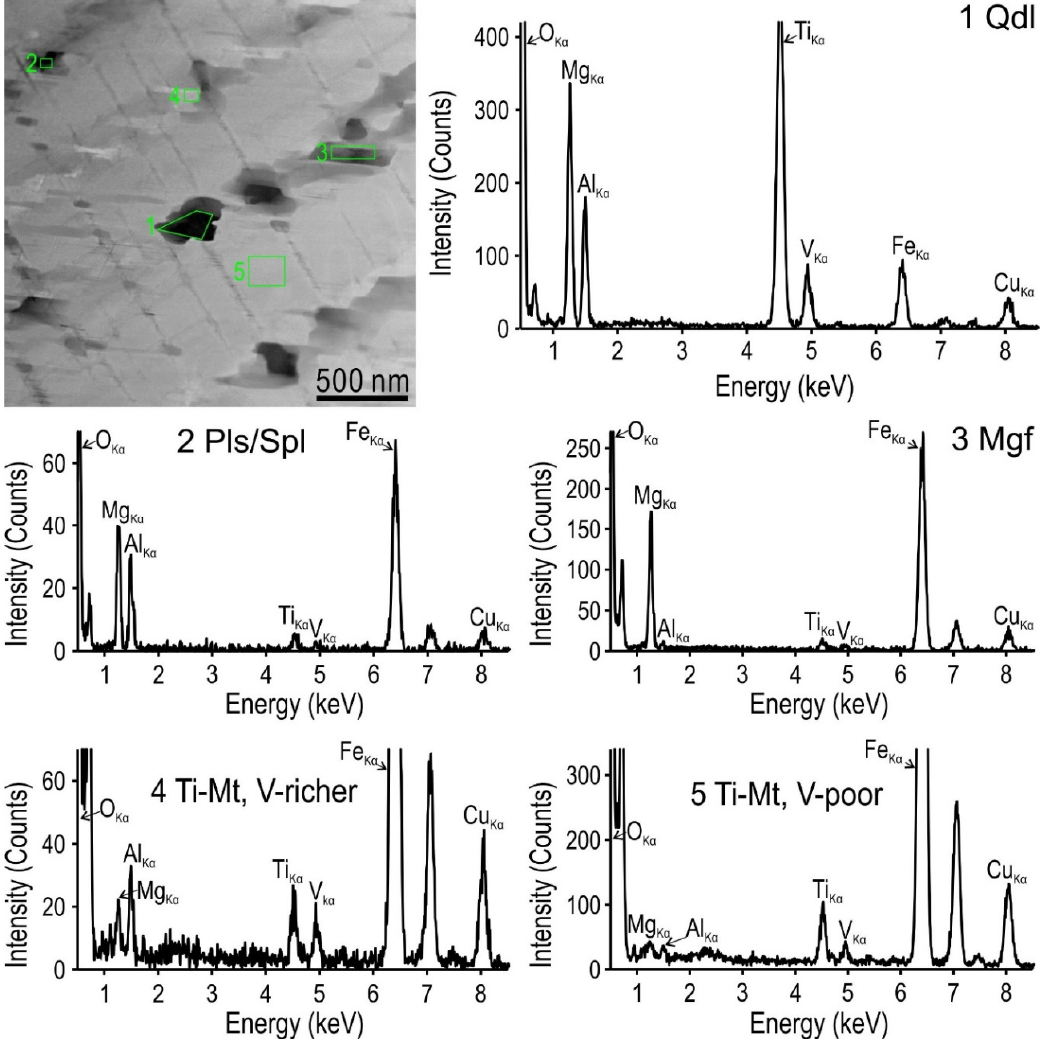
Figure 7. HAADF STEM image (top left) and STEM EDS spectra 1–5 obtained from areas, as marked on the image. The spectra show the presence of variable spinel types, as marked. Magnetite with variable Ti and V content is also present. The high Fe peak is partially due to the shallowness of the spinel mineral inclusions. The Cu peak is from the TEM grid. Note: Mgf = magnesioferrite; Mt = magnetite; Pls = pleonaste ; Qdl = qandilite; Spl = spinel.